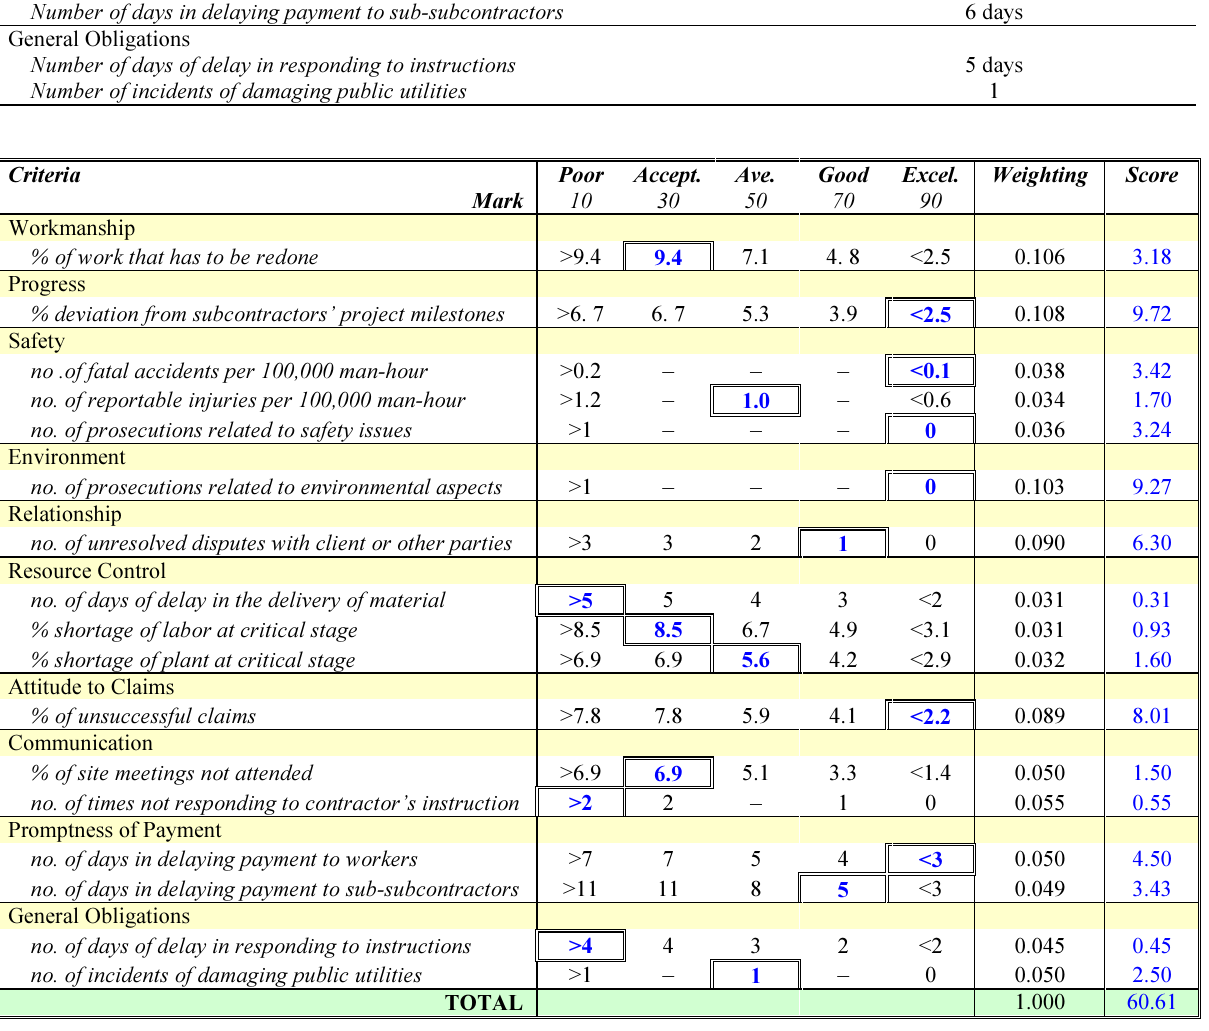
Fig. 2. Example of a completed balanced